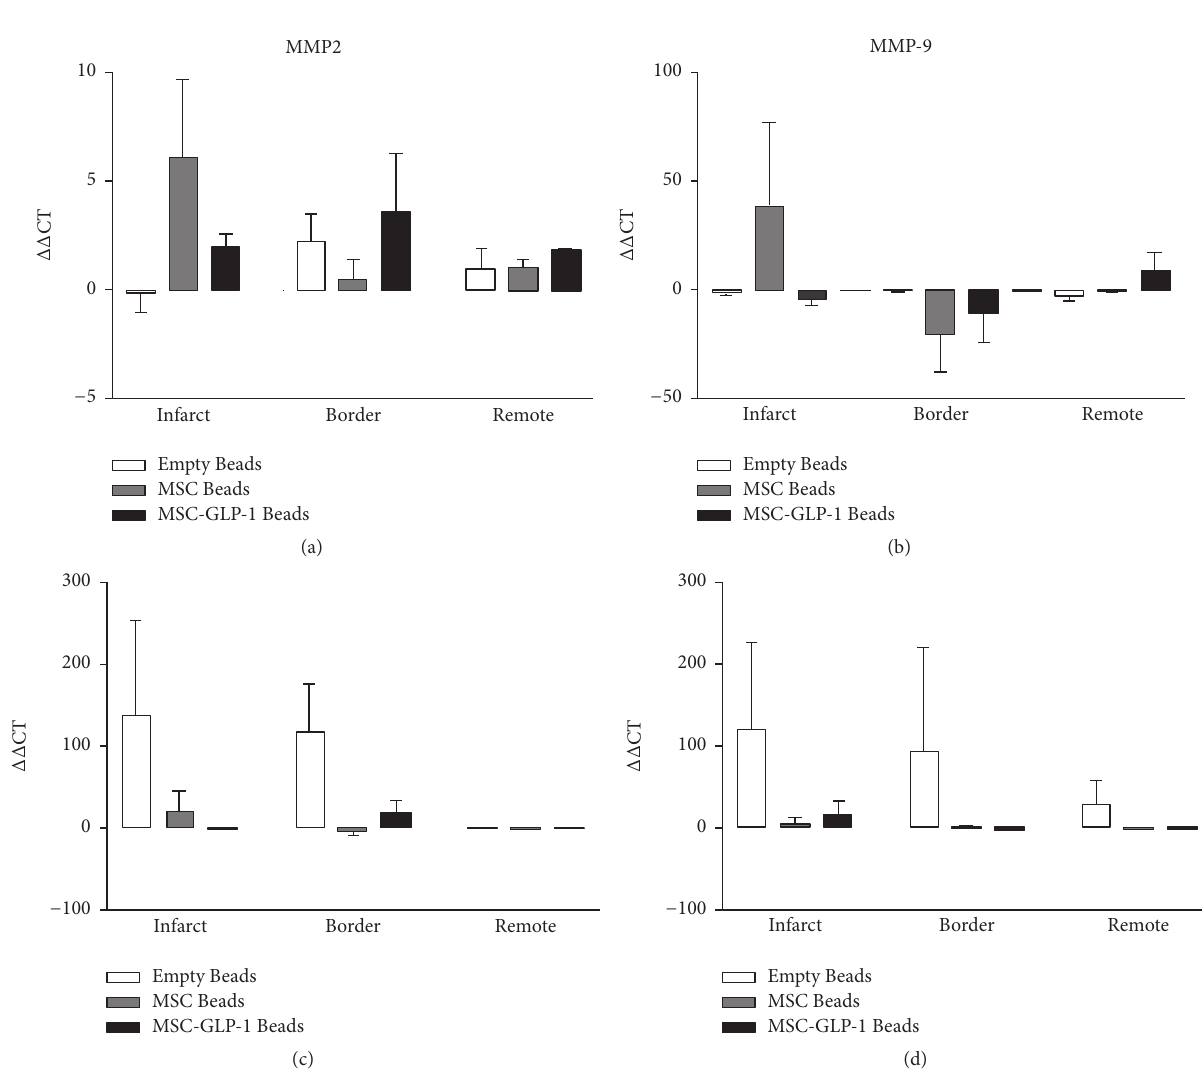
Figure 4: Quantification of MMP2 and MMP9 mRNA levels. No significant differences were observed between MMP2 (a) and MMP9 (b) mRNA levels within myocardium from infarct, border, and remote zones one week after MI. At four weeks after MI, increases in MMP2 (c) and MMP9 (d) mRNA levels were observed in the Empty Bead group in both infarct and border regions of pig heart after myocardial infarction. 𝑁 = 3 – 5 per group; however these differences were not